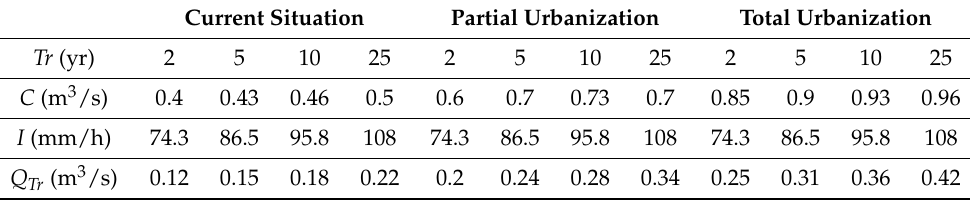
Table 2. Flood design and rainfall intensity within four return periods according to level of urbaniza- tion for the micro-watershed area of 0.014 km 2